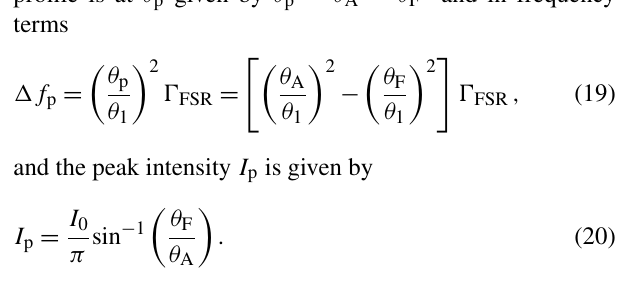
Figure 13. Dispersion curves of frequency shift versus angle of in- cidence for beams of different angular aperture (FOV) with θ F = 0 as corresponding to the ideal case (green), θ F as corresponding to the internal reference beam (red), and = 1 . 44 / 2mrad as corresponding to the atmospheric signal θ F ATM beam (black). The frequency shift between internal reference signal and atmospheric signal at nominal incidence is close to